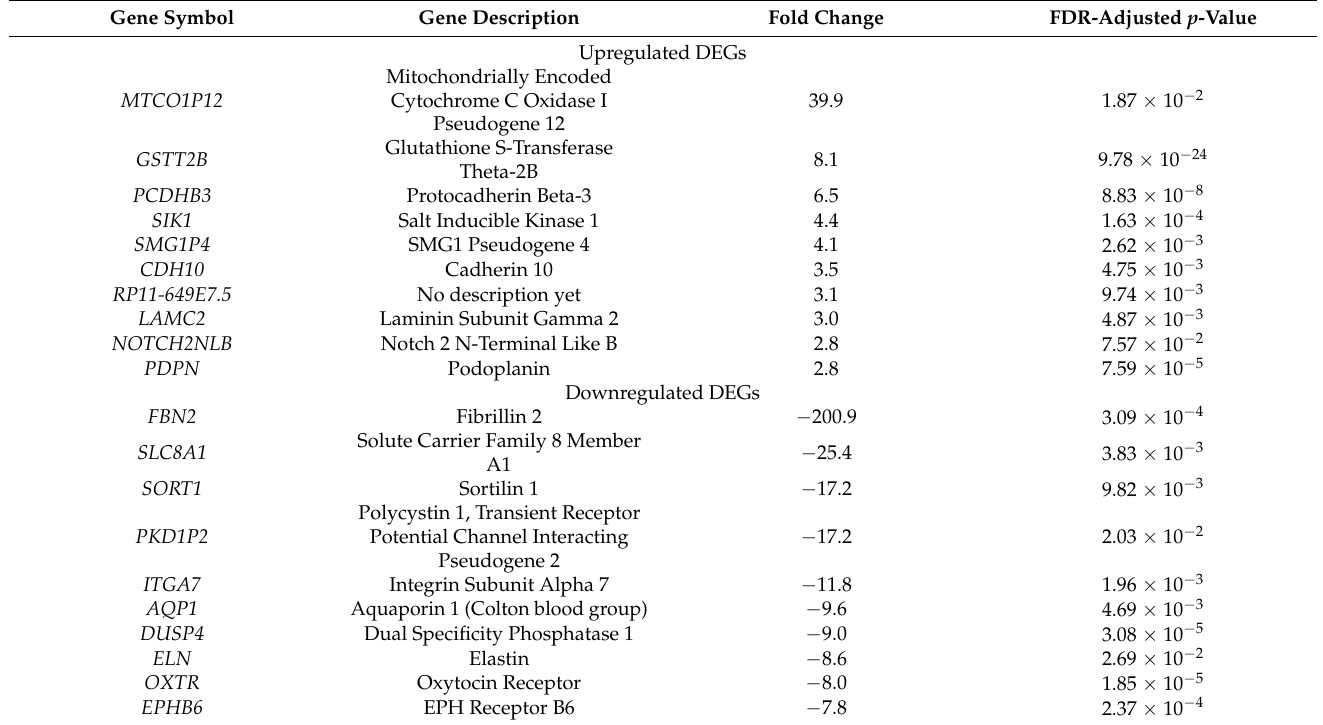
Figure 1. Genes that are differentially expressed in HKCs (TGF β 1 + CMS) vs. HCFs (TGF β 1 + CMS). Downregulated genes (FDR value ≤ 0.1, fold change ≤ − 1.5, and CPM ≥ 10 in at least one sample) are labeled in GREEN. Upregulated genes (FDR value ≤ 0.1, fold change ≥ 1.5, and CPM ≥ 10 in at least one sample) are labeled in RED. Genes that are not significantly changed are labeled in GREY. Top 10 upregulated and 10 downregulated in HKCs (TGF β 1 + CMS) vs. HCFs (TGF β 1 +